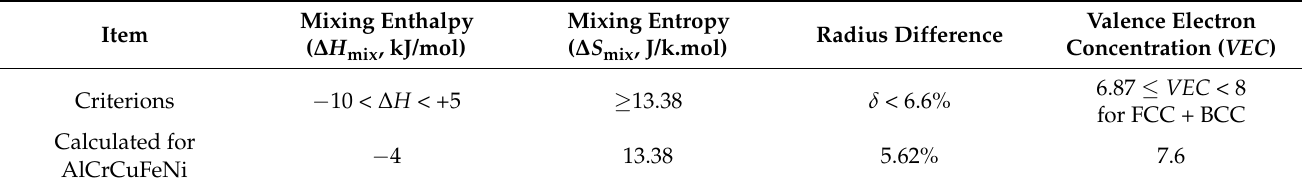
Table 1. The general theoretical criterion required for the formation of solid solution HEA and those calculated for AlCrCuFeNi